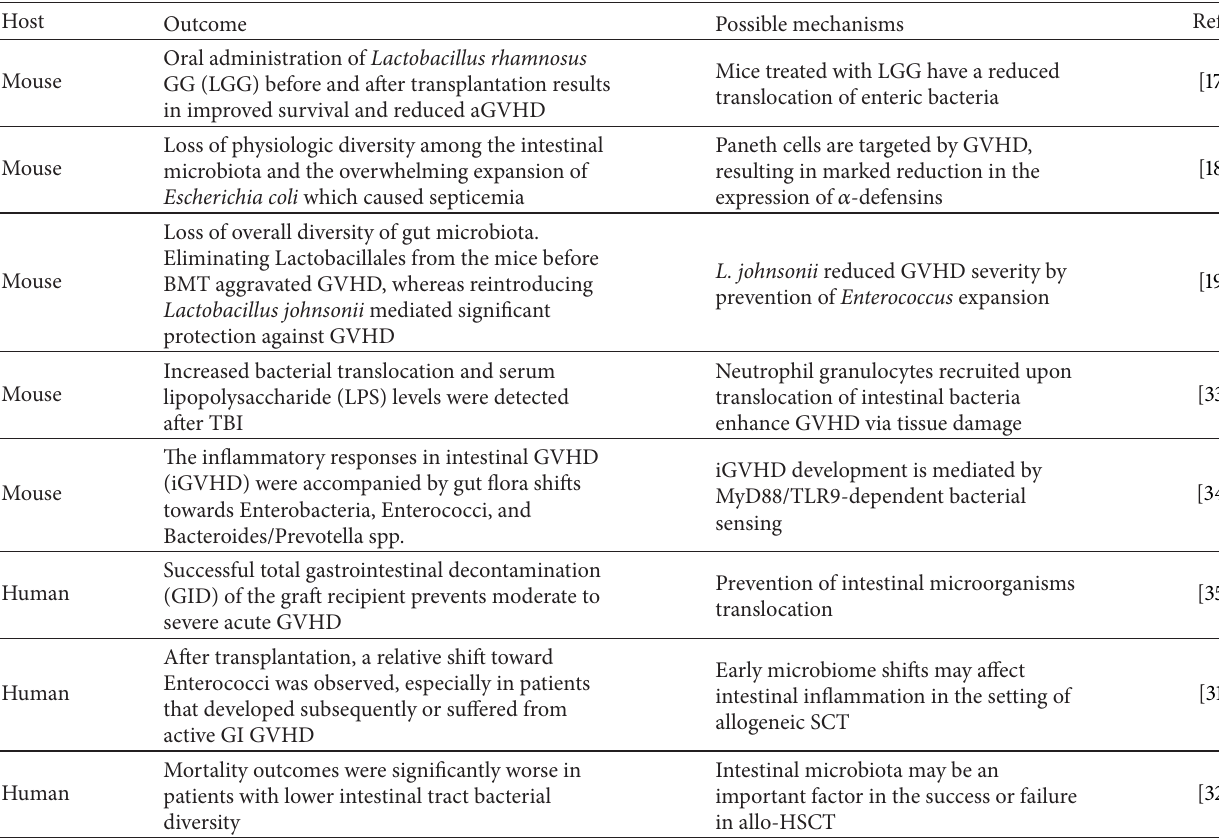
Table 1: Effect of the intestinal microbiota on